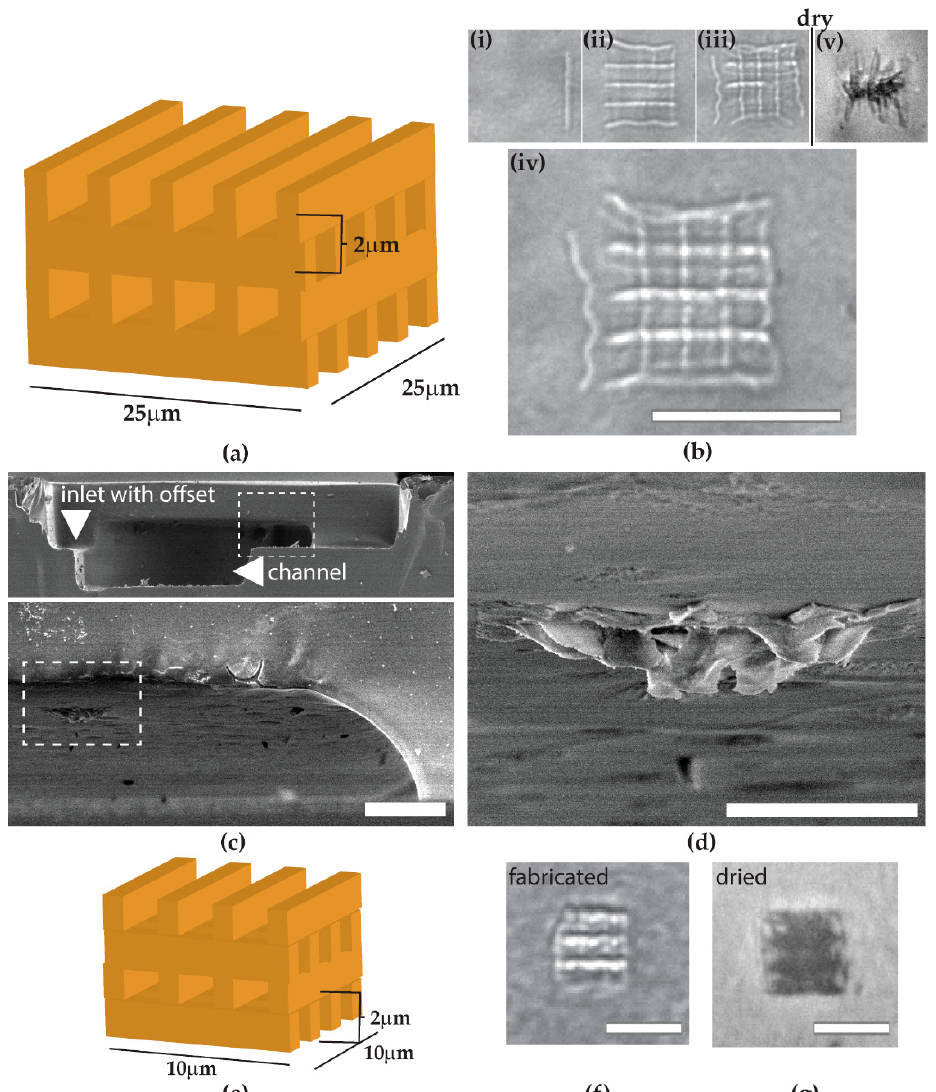
Figure 5. 3D BSA woodpile structures inside glass microchannels fabricated with a 54-MHz, 525-nm laser. ( a ) Illustration of a four-layer woodpile structure with a 2- μ m layer pitch and a 25- μ m side length. ( b ) In situ CCD camera observation of the fabrication process with 6.1 mW and 100 nm/s from ( i ) one line to ( ii ) second layer, ( iii ) last layer, ( iv ) final microcomponent, and ( v ) after drying. During the drying process, the free-hanging layers were drawn closely together, causing a collapse of the expected structure. ( c ) SEM images of the view into the microchannel. The inlet, here fabricated with an offset, and channel are indicated by arrows. The position of the woodpile is highlighted by a dashed-line rectangle. Further tilting was obstructed by the inlet. ( d ) SEM view, tilted 5°, of a woodpile structure attached inside the microchannel. ( e – g ) Fabrication of a 10- μ m woodpile: ( e ) schematic drawing, ( f ) final in situ observation, ( g ) observation after drying. The structure was lost for SEM observation when cutting the channel. Scale bars represent ( b , c ) 25 μ m and ( d – g ) 10 μ m.